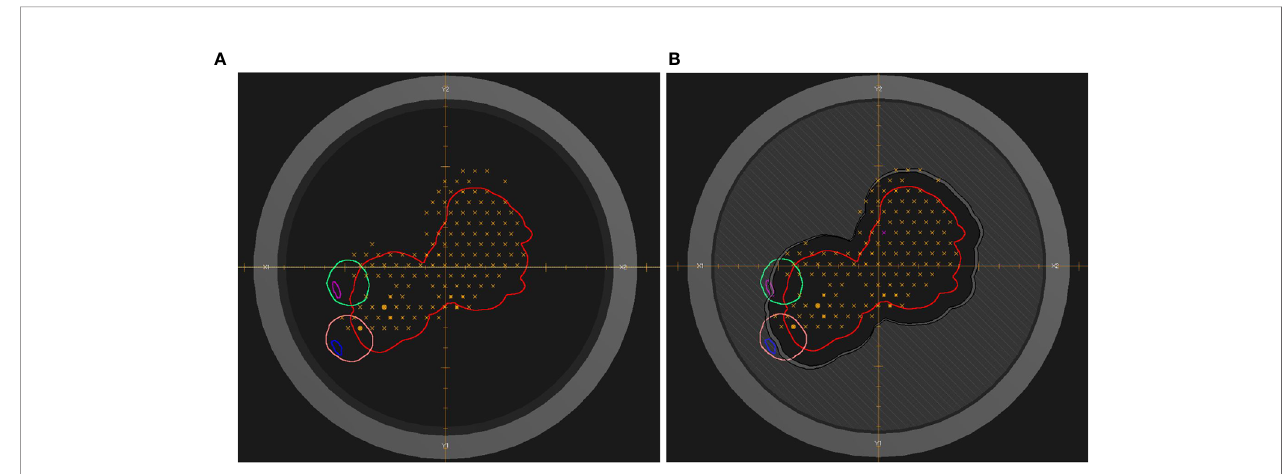
FIGURE 1 | Beams-eye view of a treatment fi eld of the uncollimated plan (A) and the treatment plan with apertures (B) . The red contour indicates the PTV. The pink (blue) and green (magenta) contours indicate the eye (lens). The dark gray hatched area visualizes the brass of the aperture. The dark gray annular ring represents the snout holder. Orange crosses and circles indicate the centers of individual pencil-beam scanning spots of one of the energy layers. The dose distribution of the treatment plan is shown in Figure 6